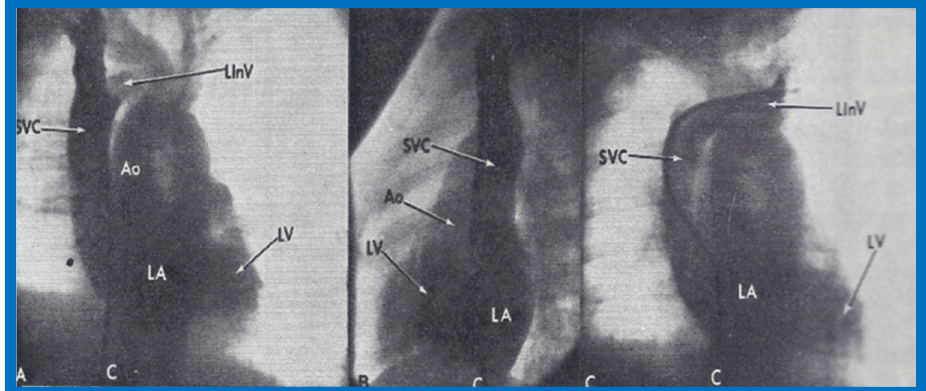
Figure 6. Angiographic frames from injections into the right innominate ( A , B ) and left innominate (LInV) ( C ) veins demonstrating direct opacification of the right superior vena cava (SVC), left atrium (LA), left ventricle (LV) and aorta (Ao) without opacification of the right heart structures. C, Catheter. Reproduced from Truman T.A., Rao P.S., Kulungara R.J.